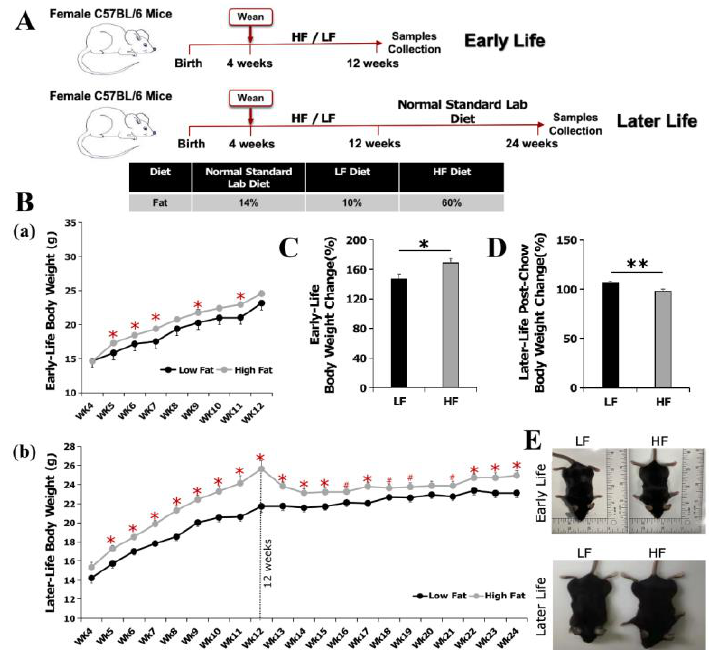
Figure 1. Experimental design and effect of high-fat diet in early life on body weight. ( A ) Experimen- tal design: one half of the animals (22) were sacrificed immediately after the 8 week experimental HF/LF diet feeding at the age of ~12 weeks, which is equivalent to the end of adolescence in humans (Early Life), and another half were terminated after the 8 week HF/LF feeding plus a 12 week normal diet feeding at the age of ~24 weeks, which is equivalent to later in young adulthood (Later Life). ( B ) Growth curves of mice sacrificed ( a ) in early life after 8 week HF/LF feeding, and ( b ) in later life after 8 week HF/LF feeding + 12 week normal diet feeding. ( C , D ) Effect of high-fat diet in early life on body weight changes (%). ( E ) Representative pictures of mice sacrificed in early life and in later life. Data are presented as mean ± SEM. n = 10–11/group. #: 0.05 < p < 0.10; *: p < 0.05; **: p < 0.01.